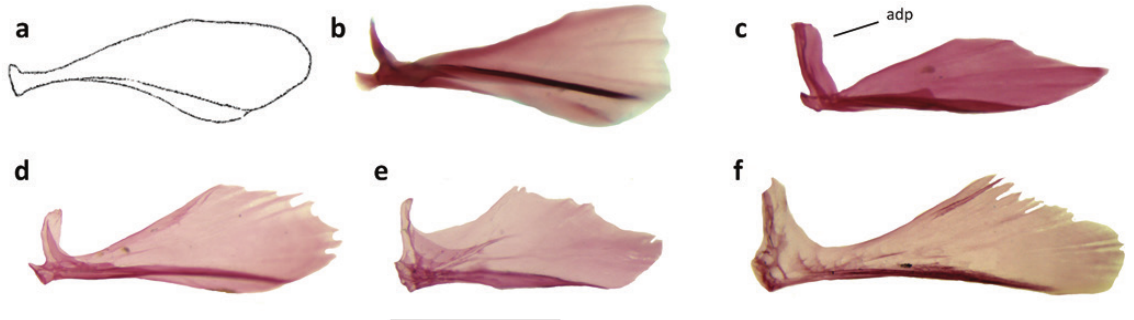
Fig. 2. Urohyal bone of a. Kryptolebias brasiliensis (modified from Costa, 2004), b. Atlantirivulus aff. paranaguensis , c. Cynopoecilus melanotaenia , d. Ophthalmolebias constanciae , e. Austrolebias juanlangi , f. Austrolebias wolterstorffi ; adp = anterodorsal process. Scale bar = 1 mm.